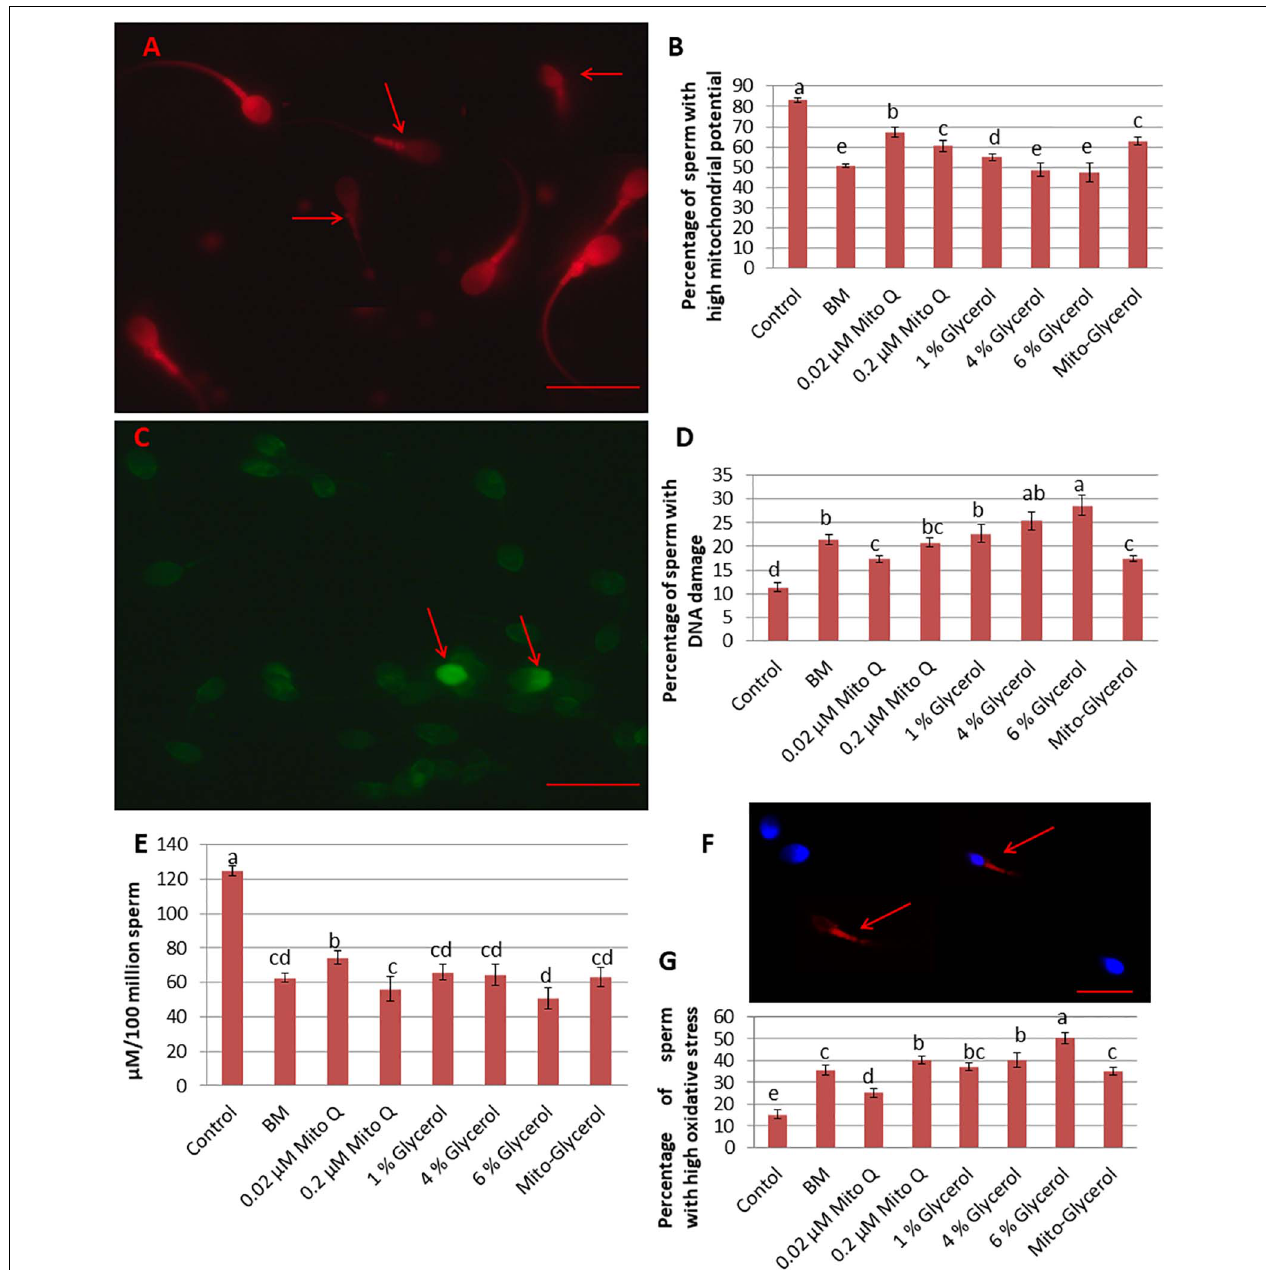
FIGURE 2 | Effect of vitrification on spermatozoa mitochondrial membrane potential, DNA damage, ATP damage, and oxidative stress. (A) Tetramethylrhodamine (TMRM) staining. High mitochondrial potential: high fluorescence of the mid-piece region of the spermatozoa; low mitochondrial potential: low fluorescence of the mid-piece region of the spermatozoa ( red arrow ). (B) TUNEL staining. Light green spermatozoa head: intact DNA; bright green spermatozoa head: damaged DNA ( red arrow ). (C) Percentage of spermatozoa with high mitochondrial potential in fresh and vitrified spermatozoa. (D) Percentage of spermatozoa with damaged DNA in fresh and vitrified spermatozoa. (E) ATP production per 100 million spermatozoa by fresh and vitrified spermatozoa. (F) CellROX Deep Red staining. Middle piece stained pale red or no color : low oxidative stress; middle piece stained intense red ( red arrow ): high oxidative stress. (G) Percentage of spermatozoa showing high oxidative stress in fresh and vitrified spermatozoa. MitoQ , mitoquinone; BM , basal vitrification medium; Gly , glycerol; Mito-Gly , 0.02 µ M MitoQ and 1% glycerol. Values with different letters differ significantly ( p < 0.05). n = 20, where n is the number of times the experiment was replicated. Scale bar = 50 µ